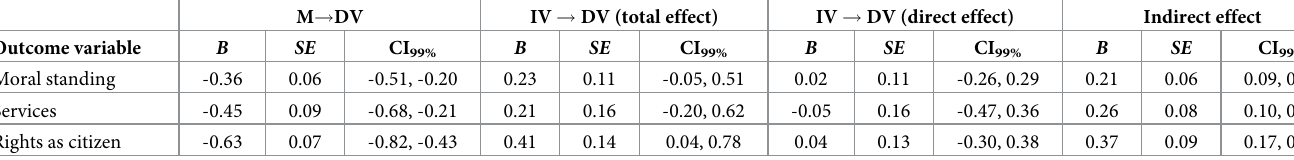
Table 7. Mediation model statistics: Effects of recovered agency on rights via dangerousness (Study